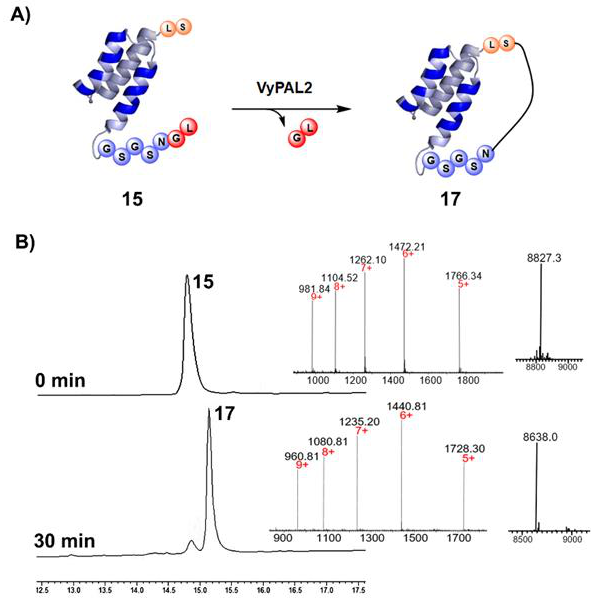
Figure 4. VyPAL2-mediated protein macrocyclization.